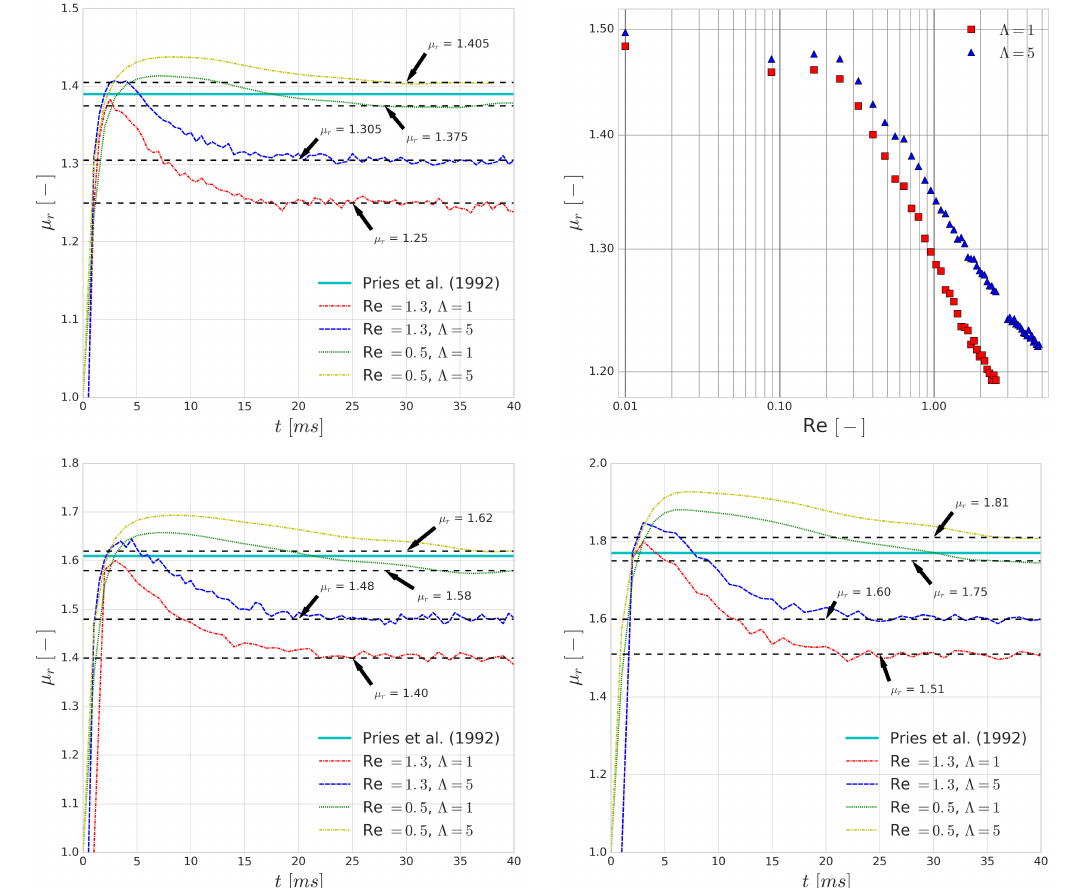
Figure 12. ( Top left ) The relative apparent viscosity of blood in the straight circular channel flow simulation with a discharge haematocrit of 20% and a channel diameter of 70 µ m. ( Bottom left ) The relative apparent viscosity of blood in the straight circular channel flow simulation with a discharge haematocrit of 28% and a channel diameter of 70 µ m. ( Bottom right ) The relative apparent viscosity of blood in the straight circular channel flow simulation with a discharge haematocrit of 33% and a channel diameter of 70 µ m. ( Top right ) The variation of the relative apparent viscosity with respect to increasing Reynolds number for a straight circular channel flow with a discharge haematocrit of 20%, with and without the use of a viscosity contrast between internal and external